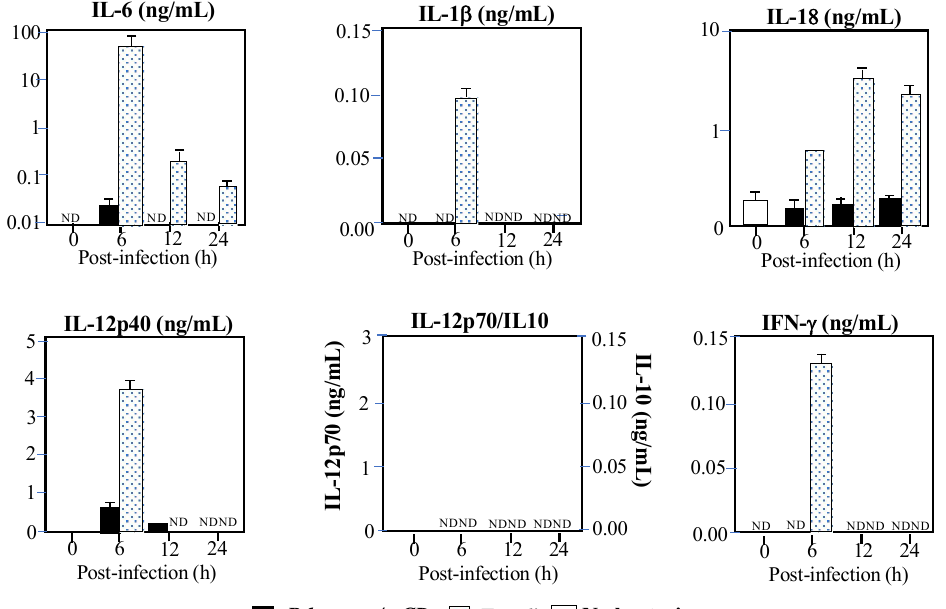
Figure 3. Production of inflammatory cytokines in C57BL/6 mice injected i.v. with cytosine deaminase of Escherichia coli (e-CD) -transformed Bifidobacterium longum ( B . longum/e-CD ) or non-pathogenic E. coli (control). Cytokines were assessed by ELISA at 6 h after injection. Closed bars, blood of mice injected with B. longum/e-CD ; dotted bars, blood of mice injected with non-pathogenic E. coli ; open bars, normal blood. IFN, interferon; IL, interleukin; ND, not detected. This figure was adopted from a previous study [10,11].